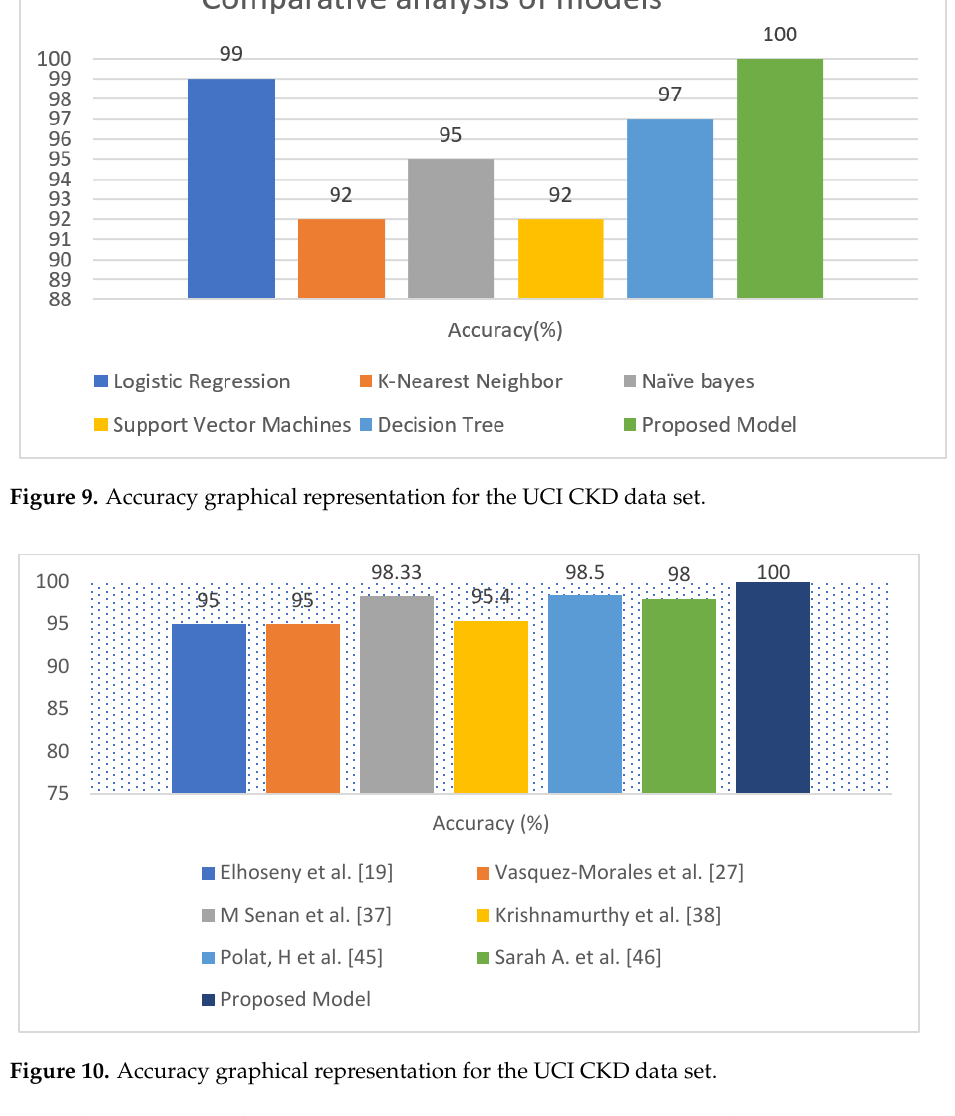
Figure 11. Important features selected by RFE. Table 7. The most critical risk factors from CKD data. Risk Factor Name Hemoglobin Serum Creatinine Red Blood Cell Count Packed Cell Volume Albumin Specific Gravity Hypertension